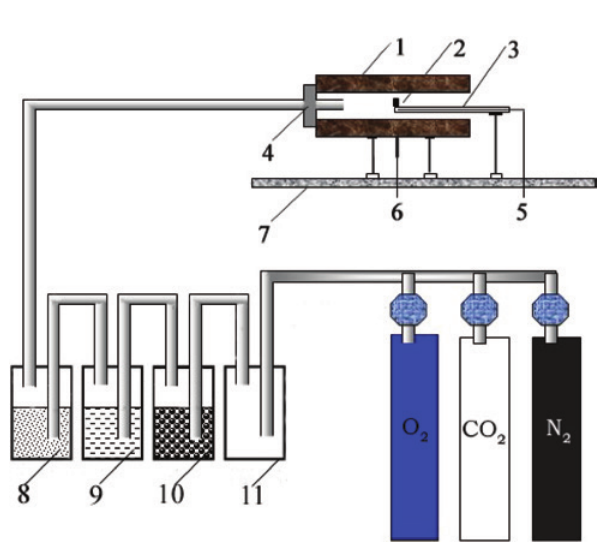
Fig. 1: Schematic diagram of the experimental apparatus. 1 – the molybdenum wound furnace, 2 – the specimen, 3 – the plate, 4 – the rubber plug, 5 – the temperature measuring system, 6 – the temperature control system, 7 – the track, 8 – the phosphorus pentoxide, 9 – the concentrated sulfuric acid, 10 – the silica, 11 – the gas mixing